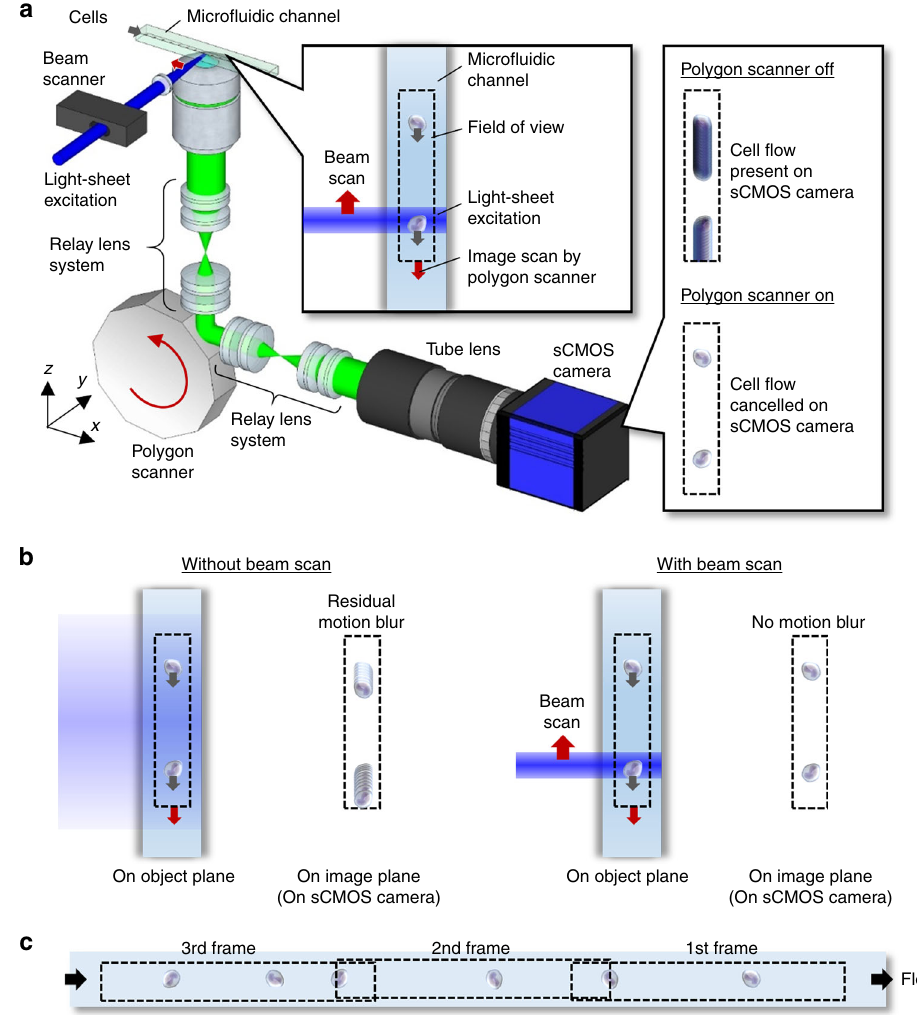
Fig. 1 VIFFI fl ow cytometry. a Schematic and functionality. The side inset shows the effect of VIFFI on the formed images of cells on the sCMOS camera. The upper inset shows scanned light-sheet excitation of cells fl owing in the micro fl uidic channel. The motion of a fl owing cell is virtually “ frozen ” on the camera by precisely canceling the motion in order to increase the exposure time of the image sensor and form a fl uorescence image of the cell with 1000- fold increase in the camera ’ s integration time. b Comparison in image acquisition on the sCMOS camera with and without the beam scan. c Serial image frames acquired by the sCMOS